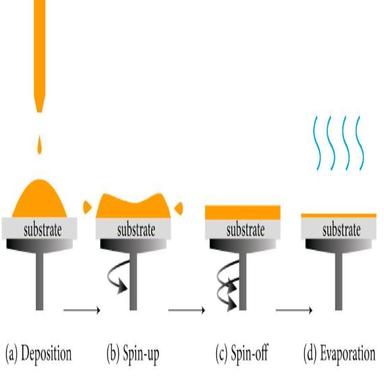
The four basic stages of spin-coating: (a) Deposition, (b) Spin-up, (c) Spin-off and (d) Evaporation.